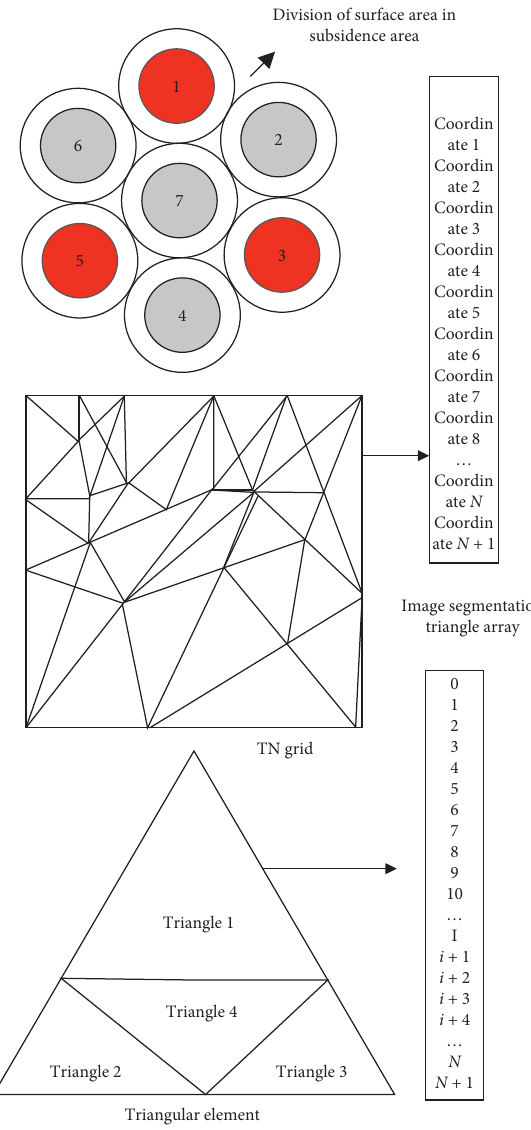
Figure 10: Framework of digital terrain model construction in subsidence